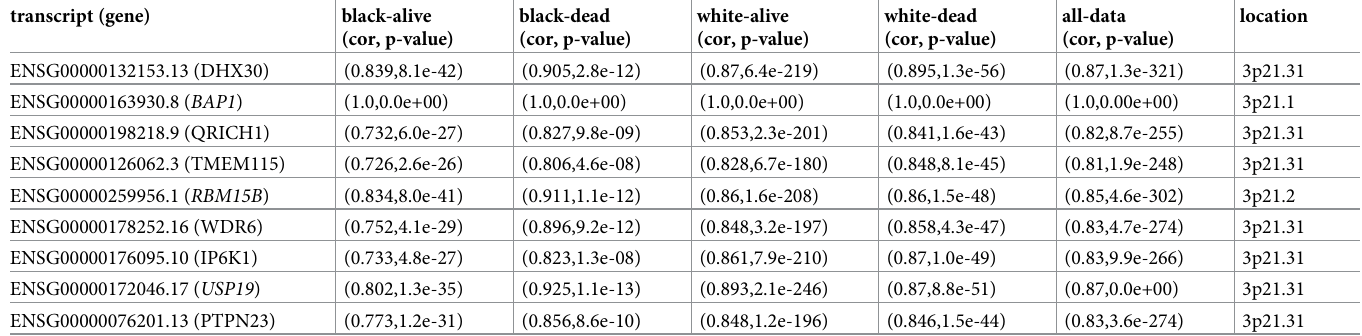
Table 5. Highly correlated genes with BAP1 in BRCA data set.